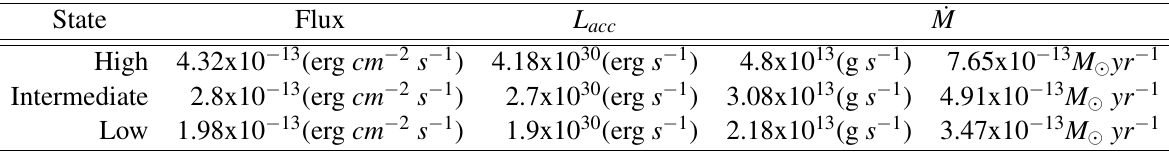
Table 8 Ultraviolet luminosities and accretion rate for the spectral line He II (1640Å